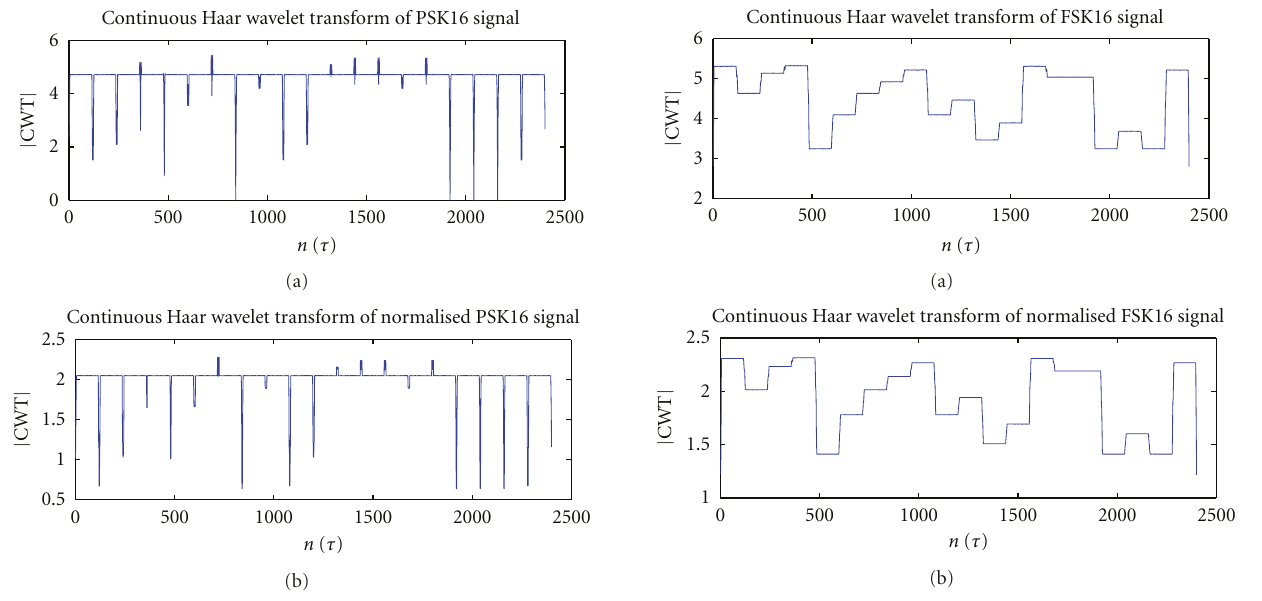
Figure 3: Constant wavelet transform of PSK16 signal and its normalized version.